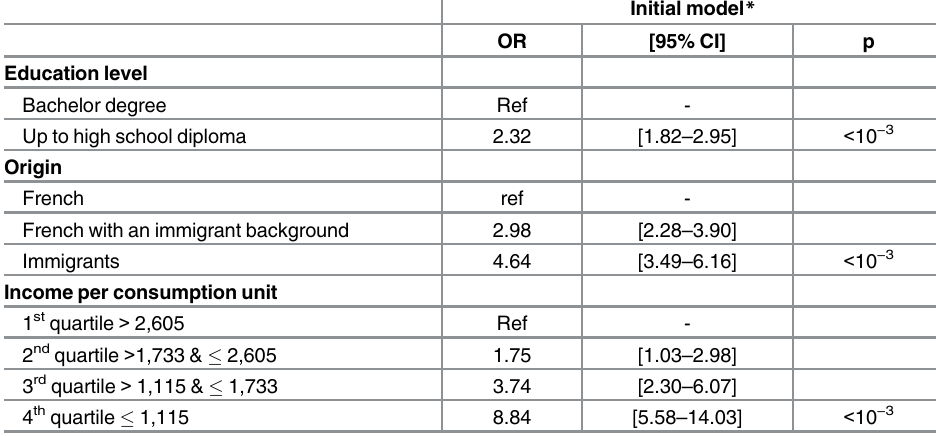
Table 3. Association between the medical cover and the individual socio-demographic characteris- tics model including each individual variable with adjustment for age and gender. (French SIRS cohort,